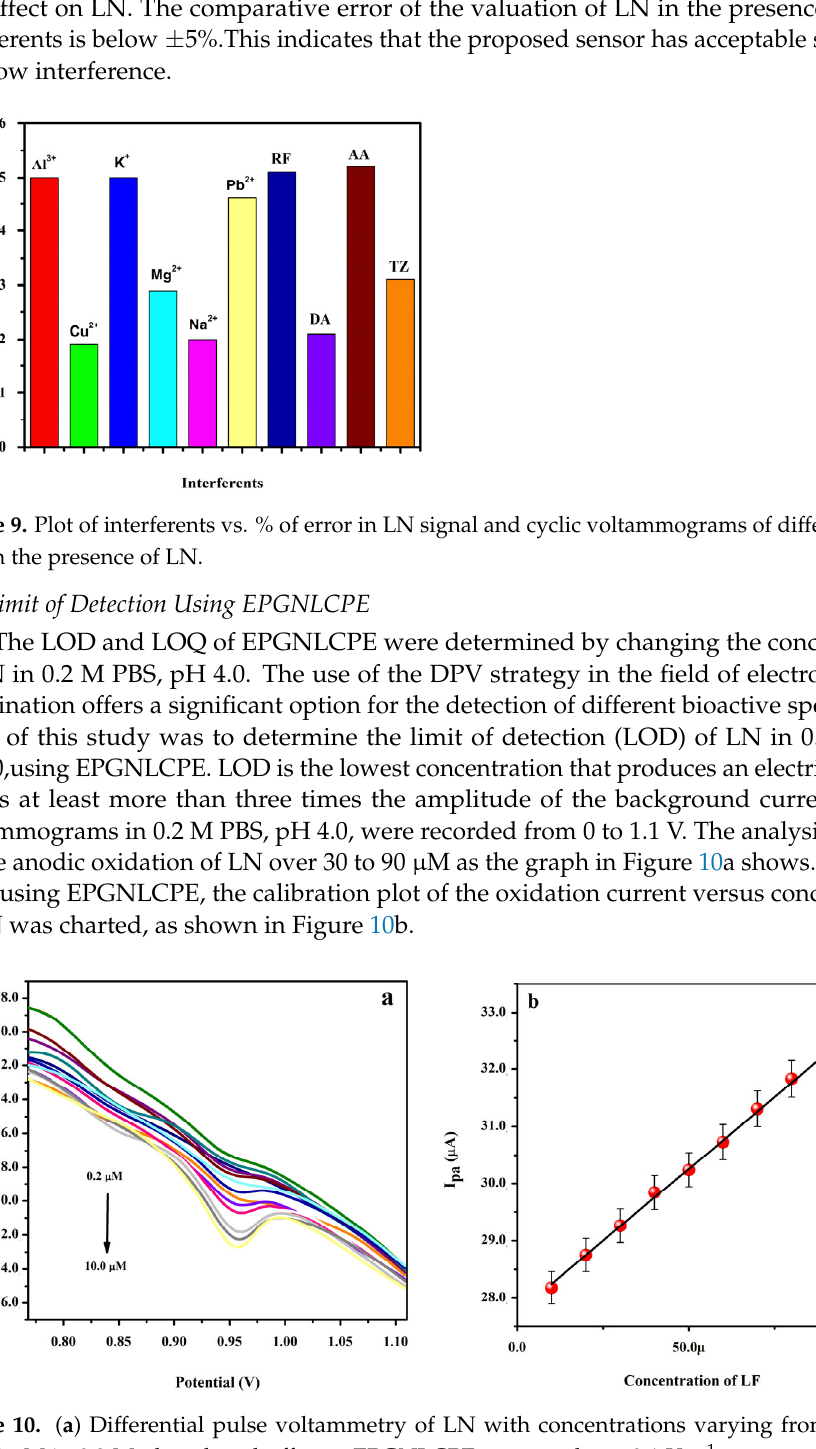
Figure 8. Probable electrochemical redox reaction of LN on EPGNLCPE surface.